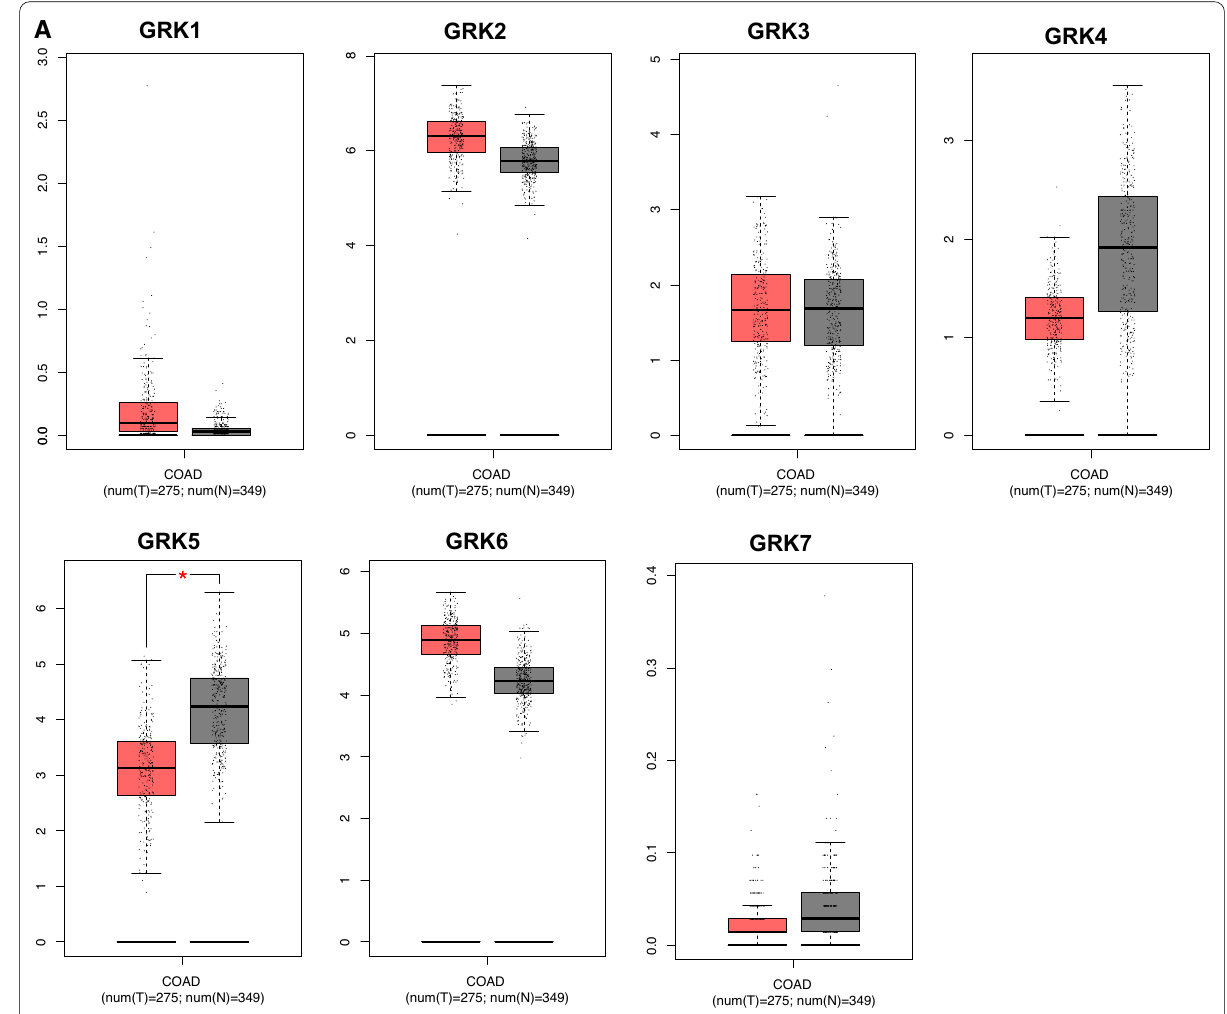
Fig. 2 A mRNA expression profile of GRK family across colon adenocarcinoma samples from TCGA study as analyzed by GEPIA. B mRNA expression profile of GRK family across colon adenocarcinoma samples from TCGA study as analyzed by UALCAN. C Differential gene expression analysis of GRKs in tumor, normal, and metastatic tissues as analyzed by